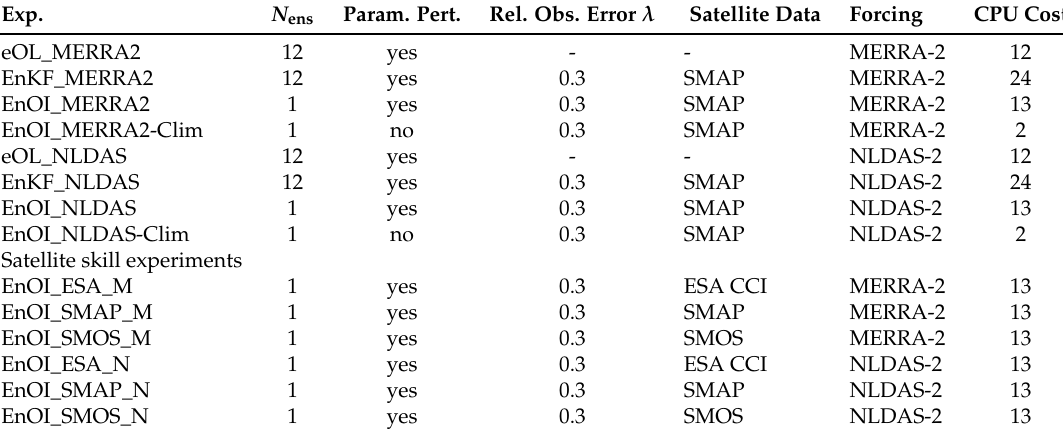
Exp. N ens Param.